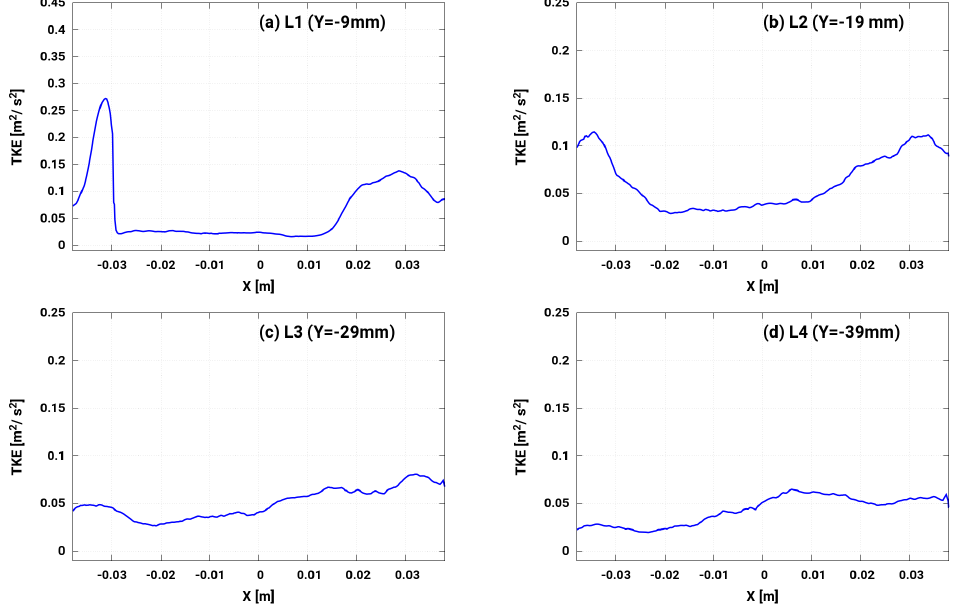
Figure 14. Turbulent kinetic energy profile at various locations (see Figure 11, bottom) on a plane at Z = 19